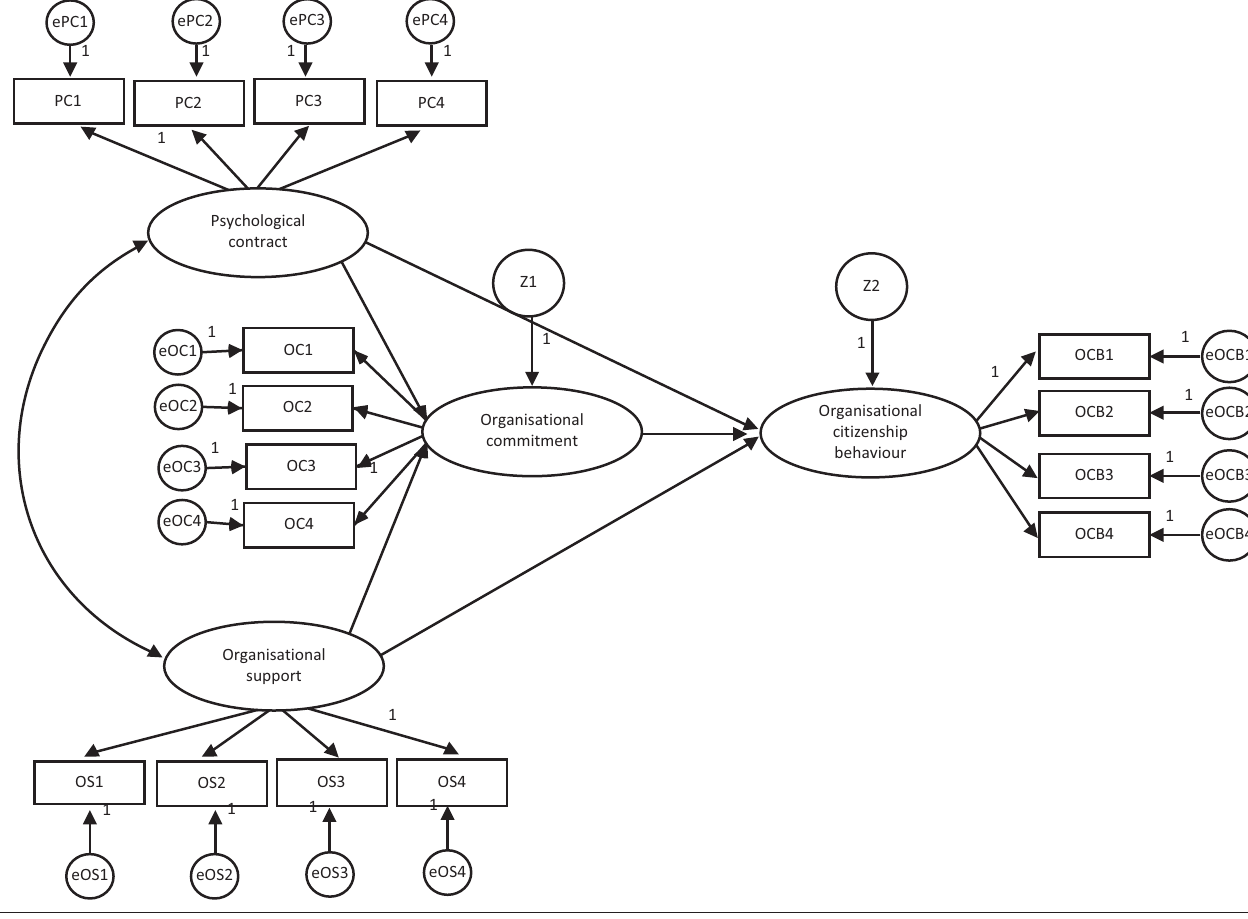
FIGURE 1: Research